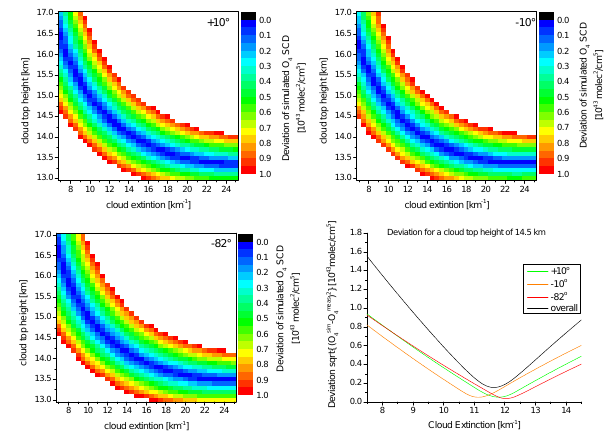
Fig. A3. Similar to Fig. A2, but for the individual viewing directions. A cross section for the cloud top height of 14.5km is shown in the bottom left. The minima for the three viewing directions are not observed at exactly the same cloud extinction, which might be caused by a small error in the simulated reference SCD. Table A1. Cloud effective radius as a function of cloud top height or cloud extinction. Here we calculated with a constant cloud water content of 948ppm. Changing the water content by ± 78ppm did not influence the effective radius significantly, the results are given as ∆ r eff .